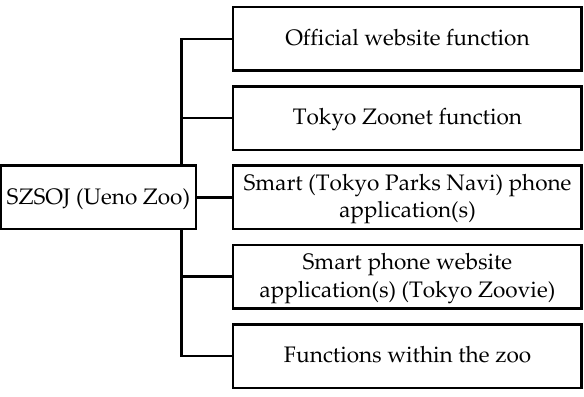
Figure 4. SWOT of the current state of Ueno Zoo.